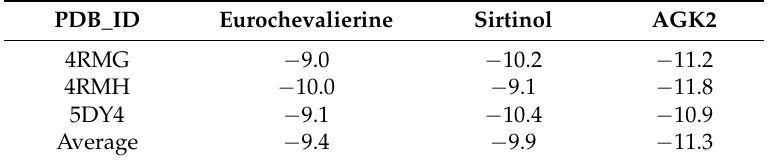
Table 3. Qualitative molecular docking results of eurochevalierine against human SIRT2 1